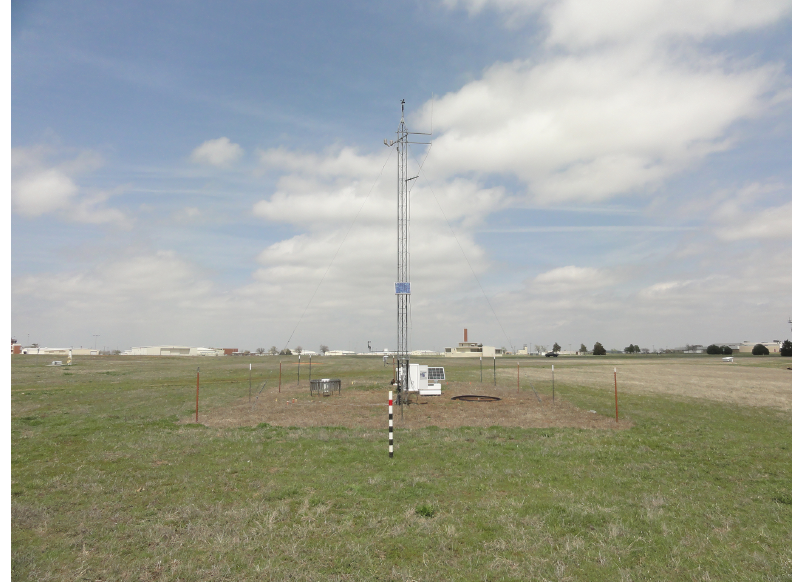
Figure 4. Norman Mesonet station from spring 2013. Image courtesy of the © Oklahoma Mesonet – 1994–2020 Board of Regents of the University of Oklahoma. All rights